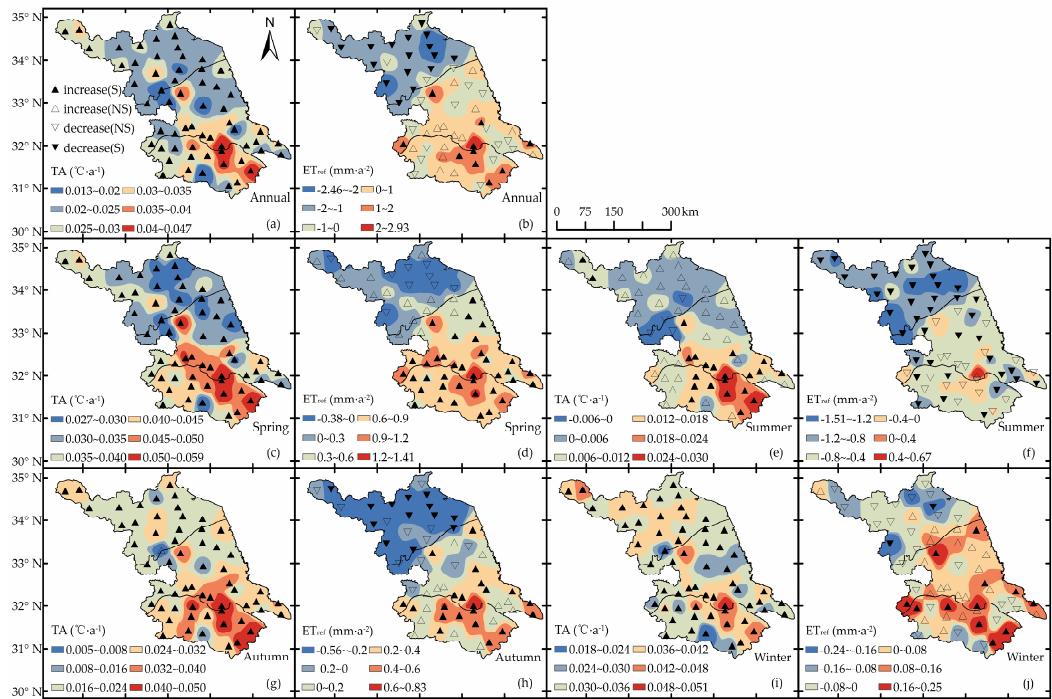
Figure 6. Spatial distributions of climate tendency rates of the TA and ET ref from 1961 to 2015 in Jiangsu province. Note: S and NS represent significant and non-significant trends at the 0.05 level of the TA and ET ref , respectively. ( a ), ( c ), ( e ), ( g ), and ( i ) represent the trends of TA in annual, spring, summer, autumn, and winter seasons, respectively, ( b ), ( d ), ( f ), ( h ), and ( j ) represent the trends of ET ref in annual, spring, summer, autumn and winter seasons, respectively.